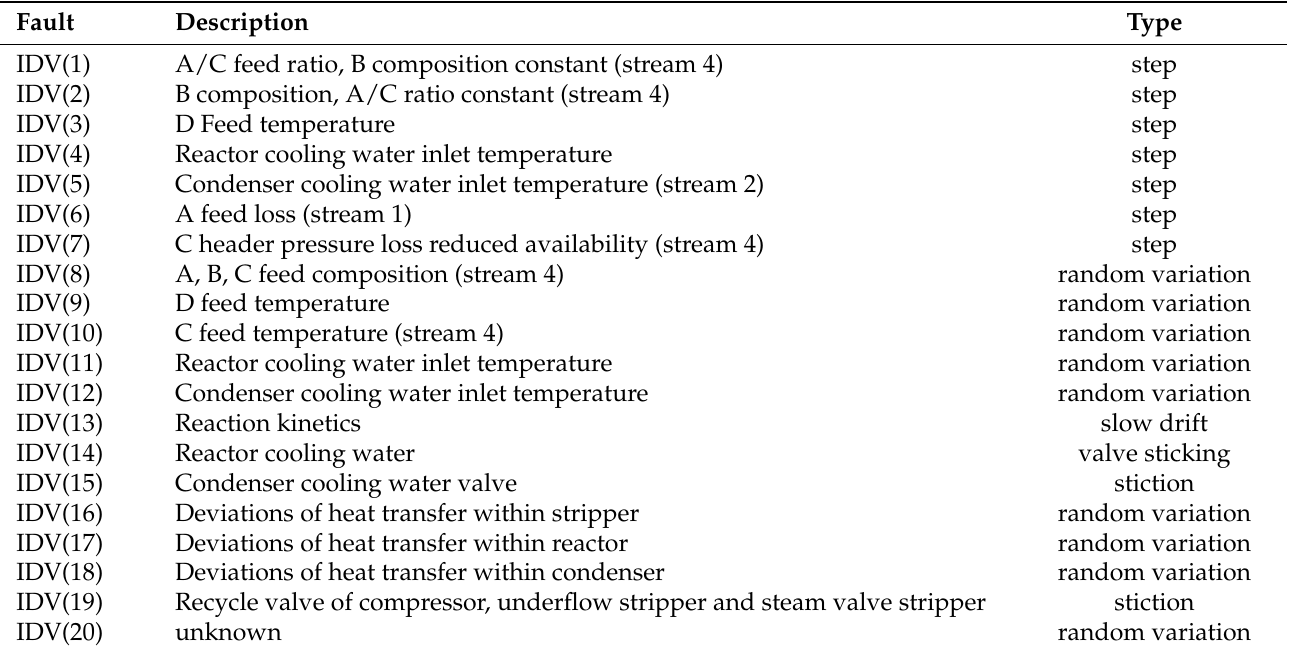
Table 2. Process faults for classification in the TE